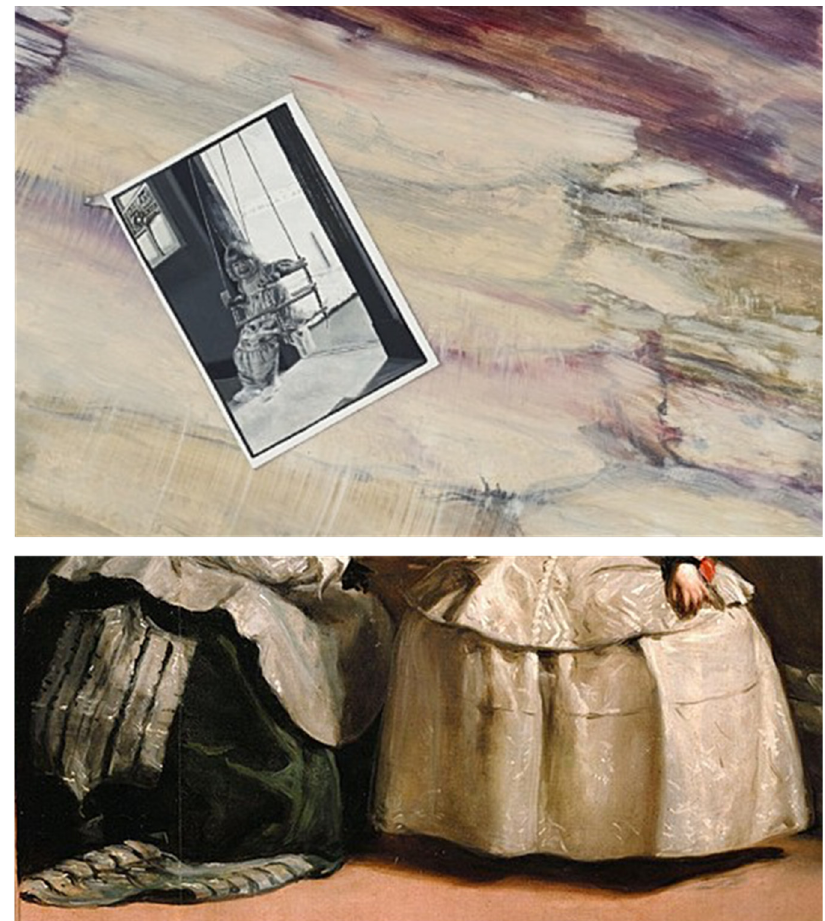
Figure 4. Details ( Top ) (McKenzie 2021). ( Bottom ) (Velázquez 1656).